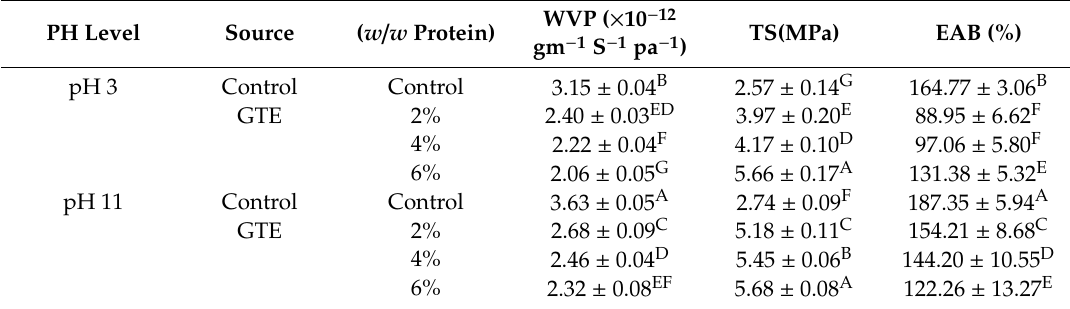
Table 2. Water vapor permeability (WVP), tensile strength (TS), and elongation at break (EAB) of films incorporated with GTE at pH 3 or pH 11 with di ff erent